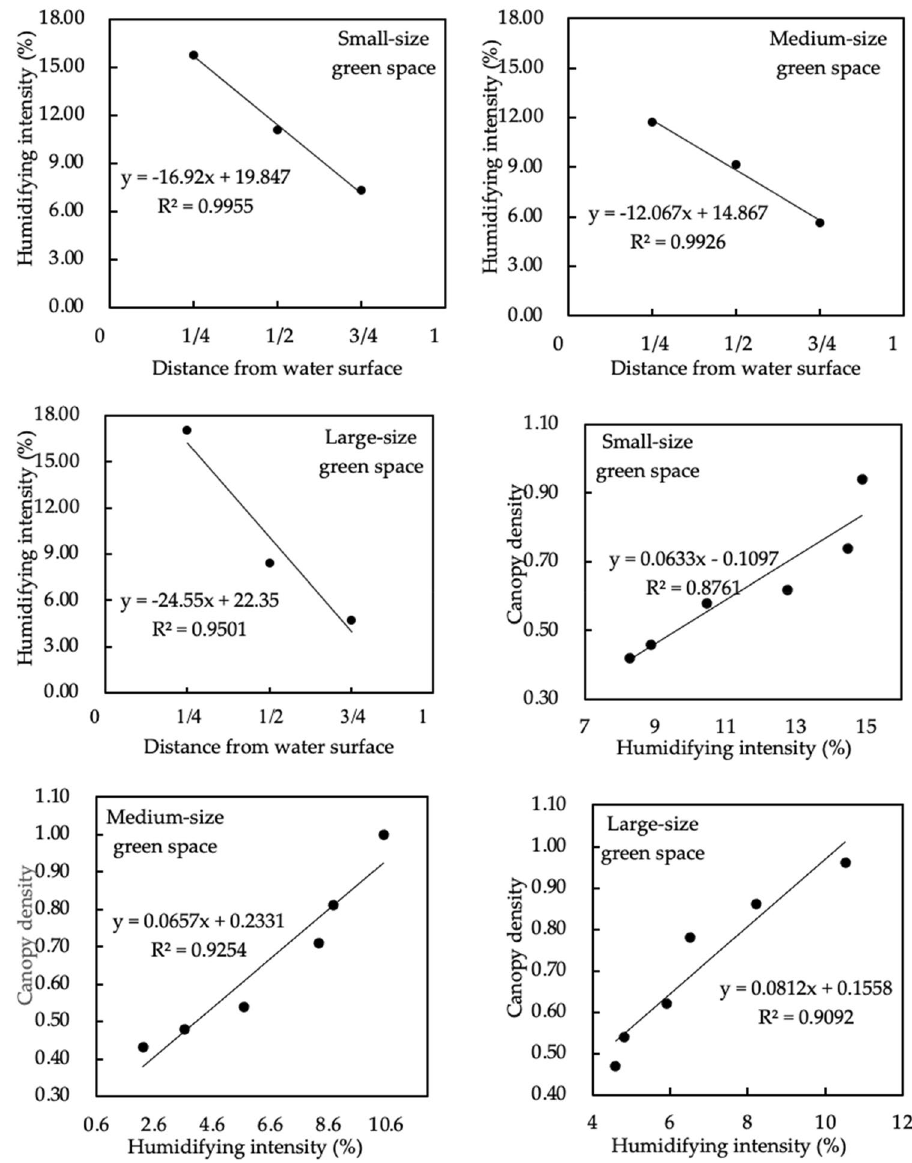
Figure 14. Linear regressions between the distance from different types of green space to water area, canopy density and humidifying